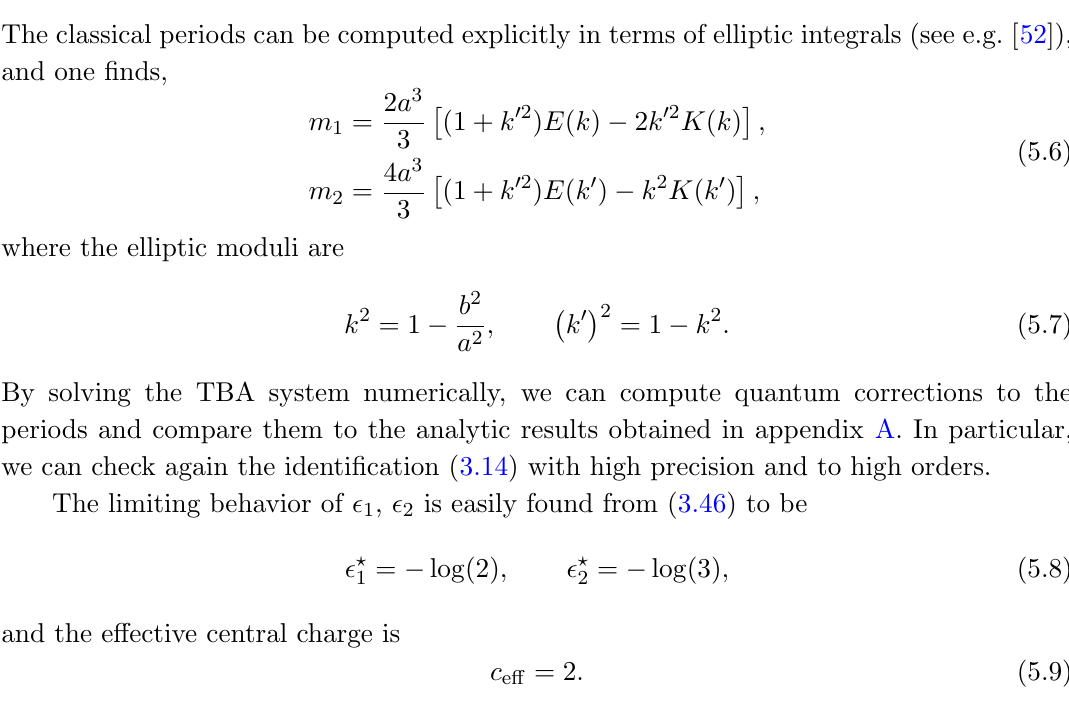
Figure 11 . The functions The horizontal lines are (cid:25) and 3 (cid:25) , and intersect of the spectrum of ~